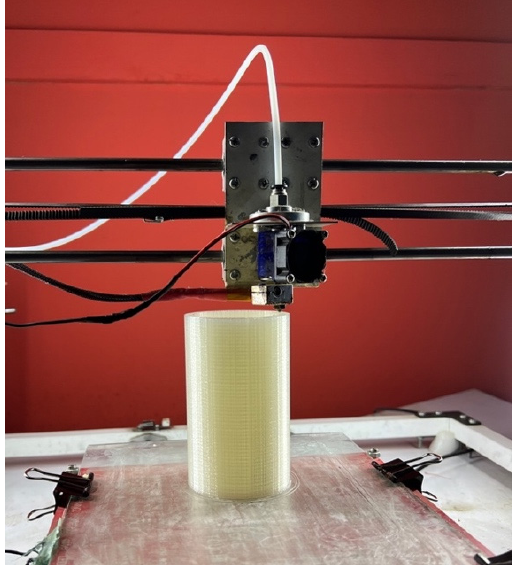
Figure 4. 3D printing of a pipe with a transparent PLA filament.